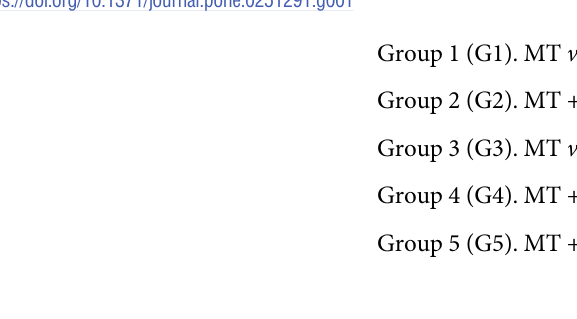
PLOS ONE | https://doi.org/10.1371/journal.pone.0251291 May 18,